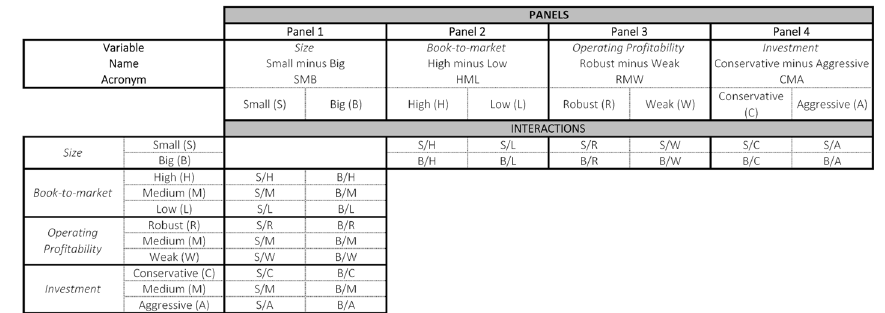
Fig. 2 Summary of portfolios by patterns. Source : Created by authors